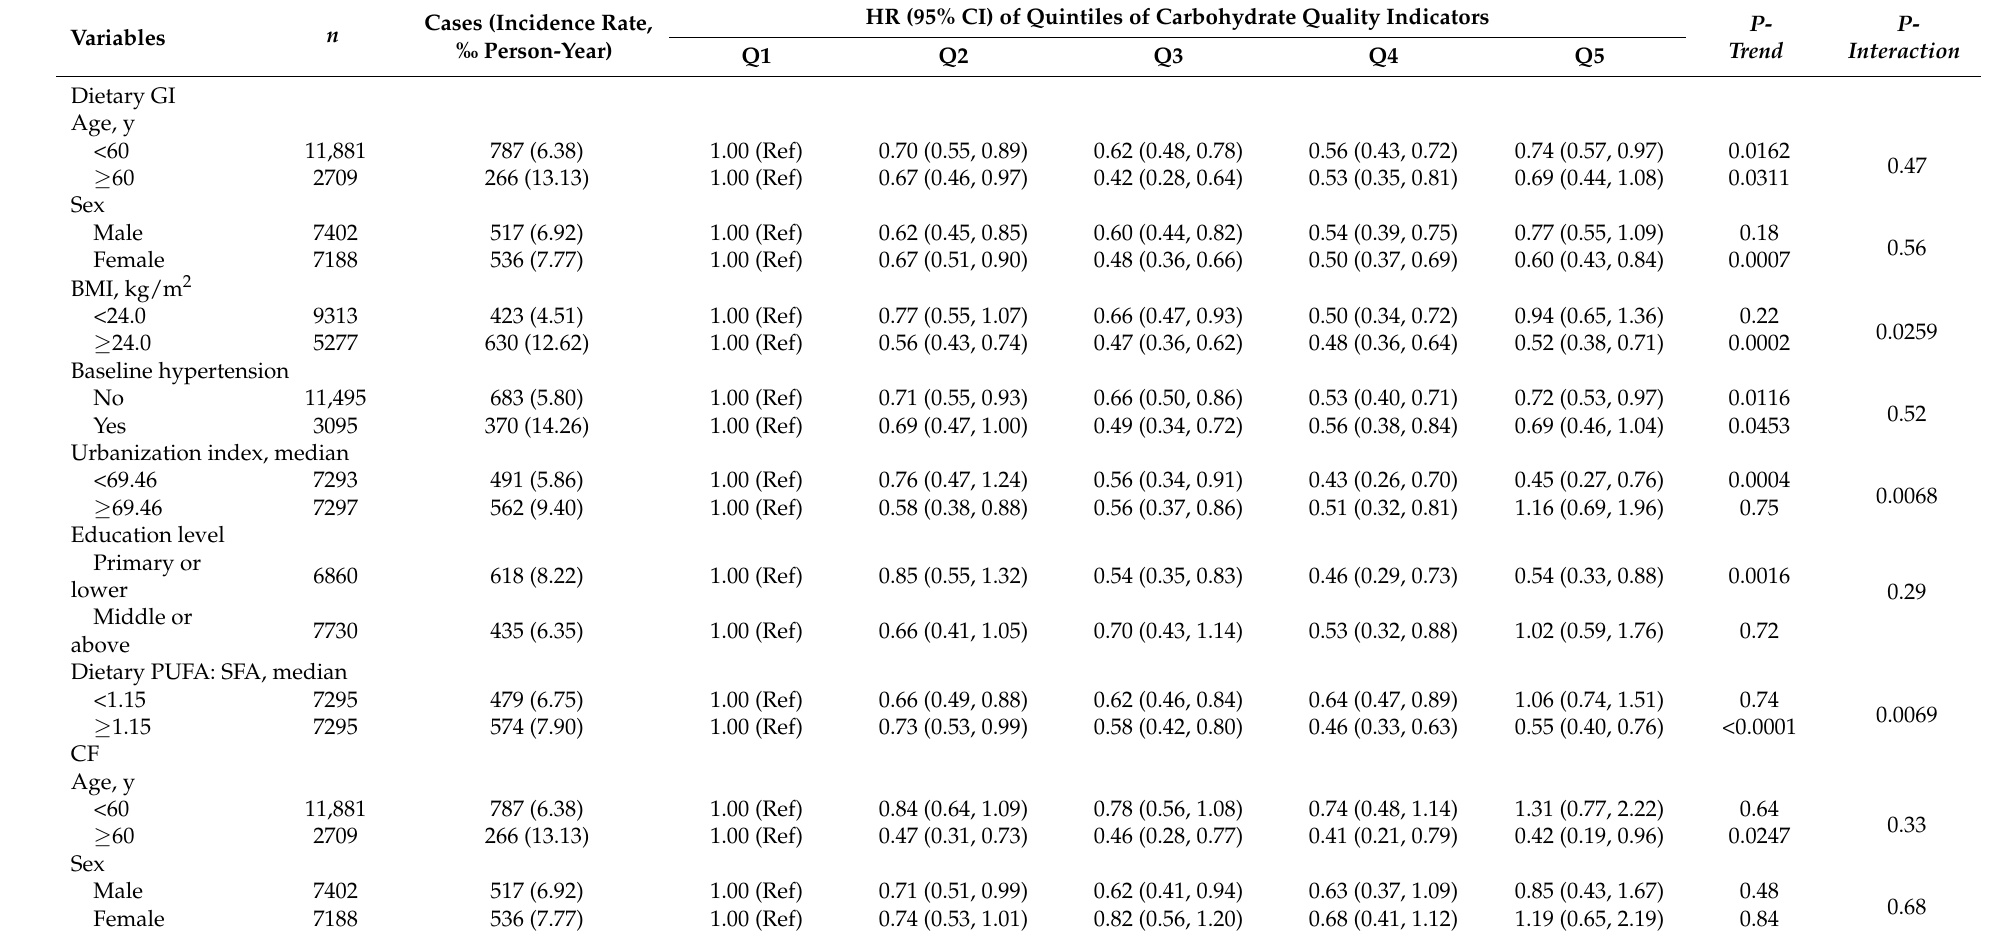
Table 3. Associations between dietary GI, CF and CQI values and T2DM risk in 14,590 Chinese adults of the China Health and Nutrition Survey 1997–2015, stratified by age, sex, BMI, baseline hypertension, urbanization index, education level and dietary PUFA to SFA ratio 1